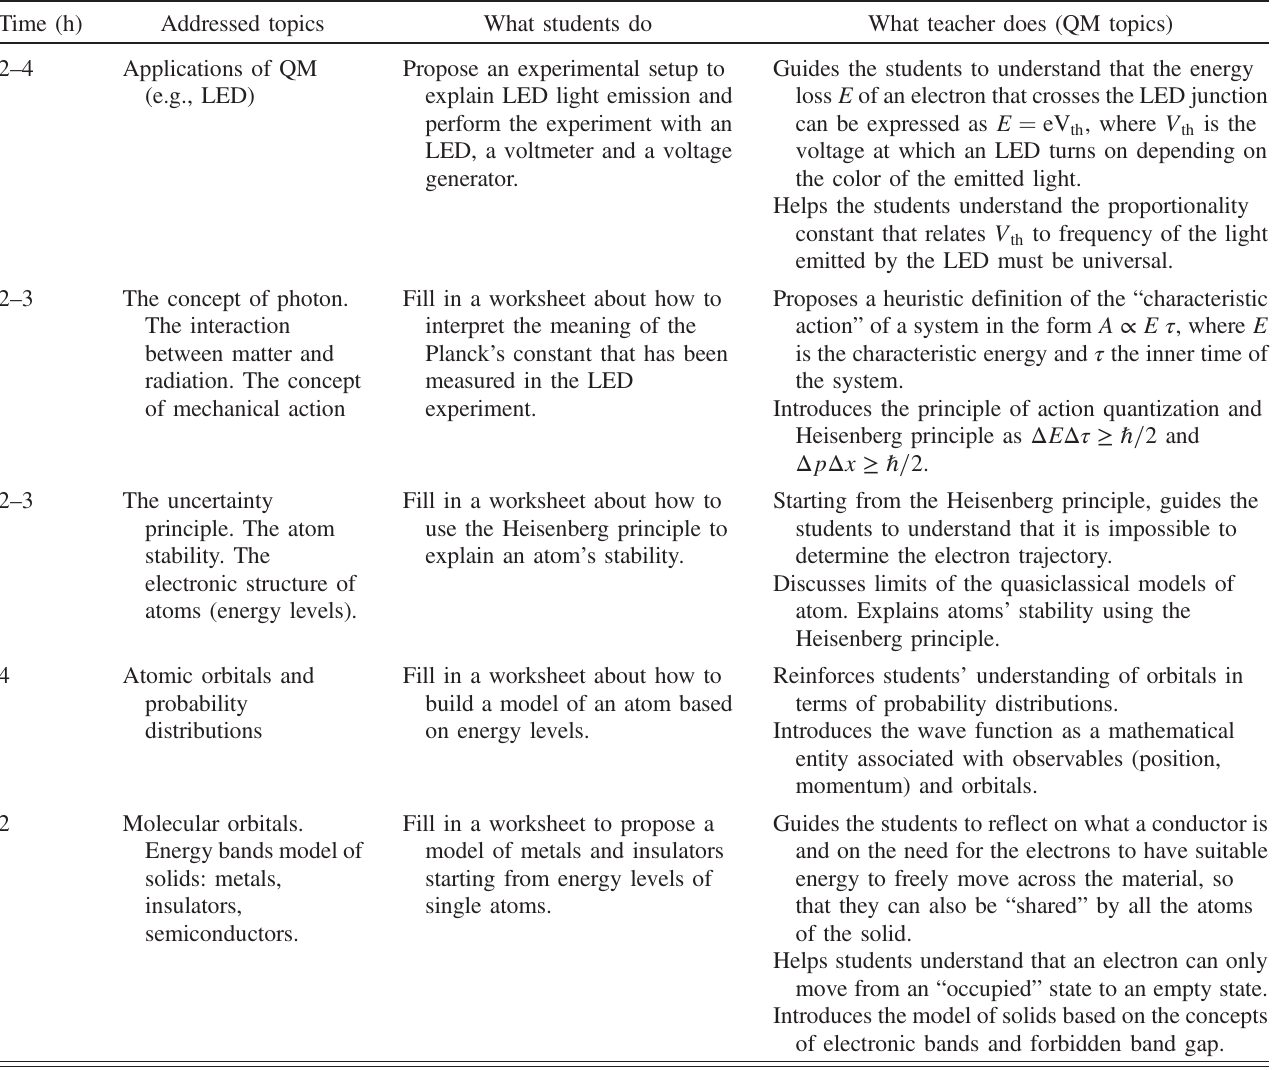
TABLE I. Summary of the transformative TLS activities used in the study (see also Ref. [47] and related Supplemental Material for more